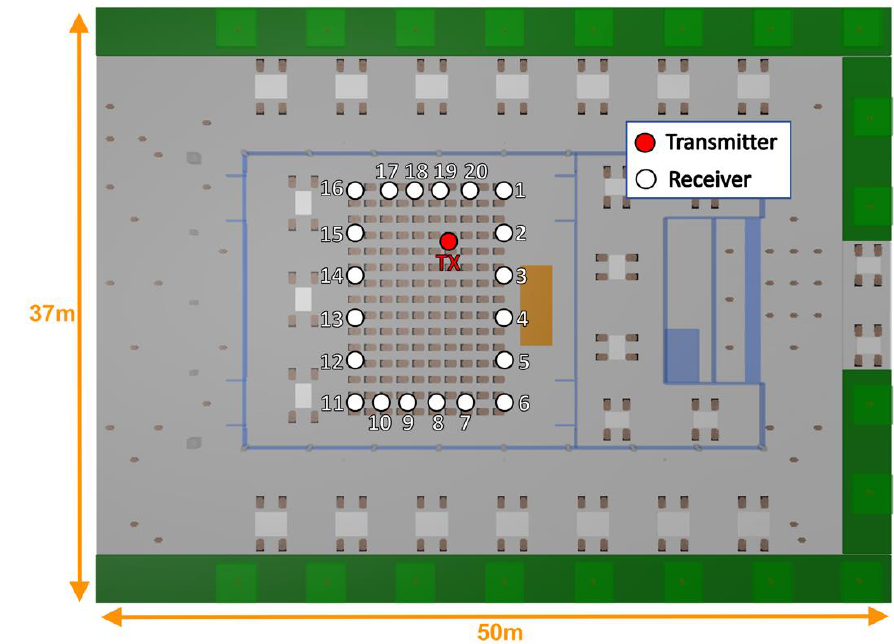
Figure 15. Transmitter position and measurement location points during the measurement campaign for the two analyzed cases: empty and full auditorium.